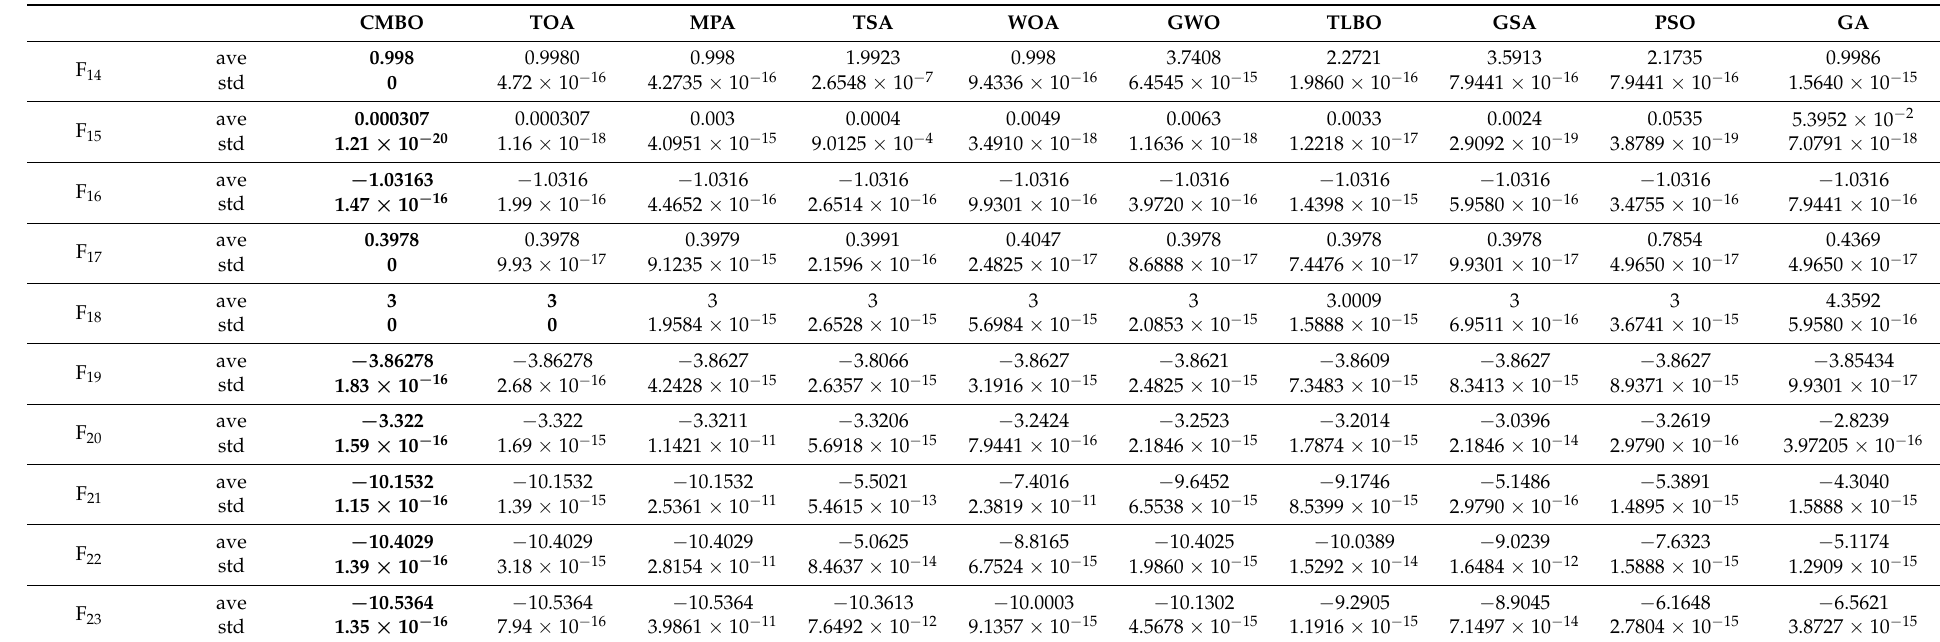
Table 6. Optimization results of CMBO and other algorithms on fixed-dimensional